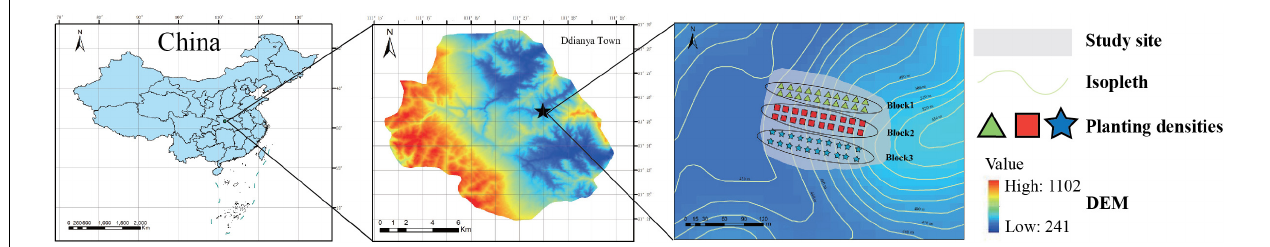
FIGURE 1 | A map of sampling locations in the experimental areas of the Daba Mountains. A diagram showing the collection of soil samples from monoculture tea (T) and walnut (W) forests and intercropping forests (W&T) in Dianya town. Green triangles, red squares, and blue stars represent monoculture tea forests (T), monoculture walnut forests (W), and intercropping forests (W&T) in study sites,